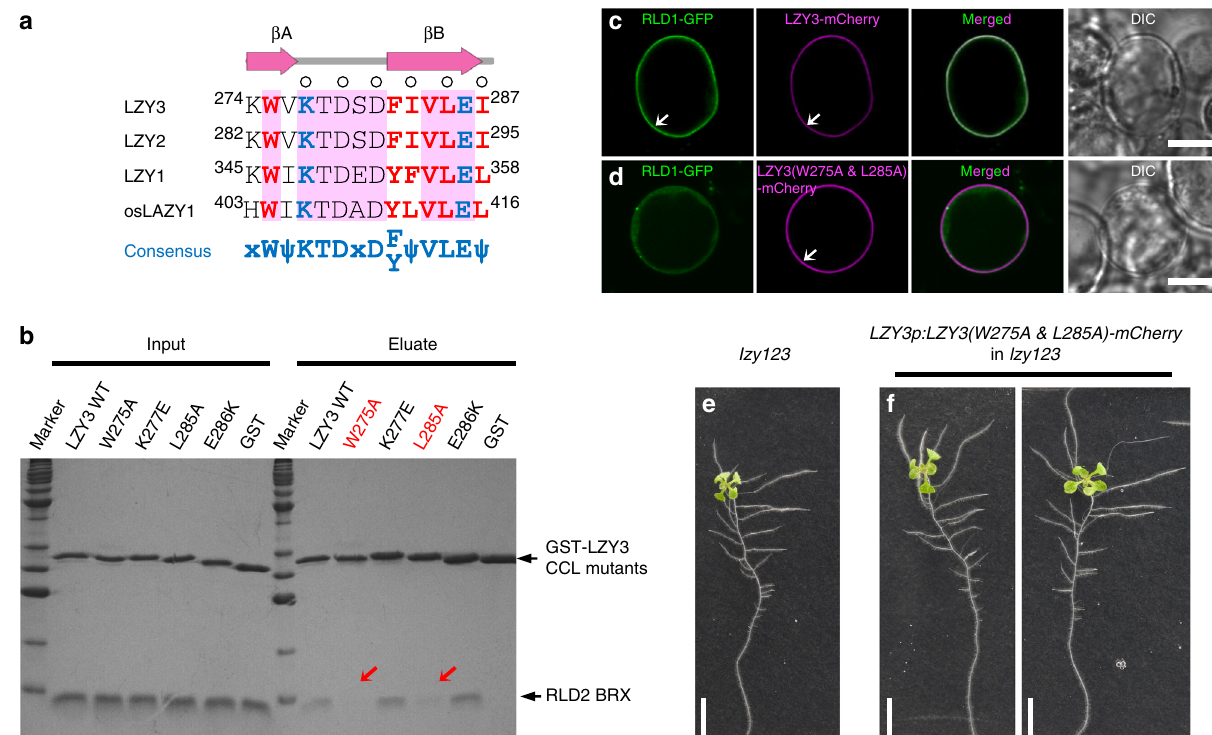
Fig. 5 The disruptive mutations of the CCL-BRX interaction interfered with LZY3 function. a Sequence alignment of LZYs CCL with the secondary structures are shown at the top with β -strands (arrowhead). The conserved sequences are fi lled in pink. Residues whose side chain atoms form inter- molecular hydrogen bonds and residues making intermolecular van der Waals contacts are colored in cyan and red, respectively, while residues whose main chain form inter-molecular hydrogen bonds are indicated with open circle. In the consensus sequence, Ψ represents a hydrophobic residue, while x represents any residue. b Pull-down binding assay. RLD2 BRX domain was pulled down with GST-LZY3 CCL (WT and mutants) and analyzed by SDS- PAGE. Arrows indicate the reduced abundance of RLD2 BRX. c , d The importance of CCL-BRX interaction in LZY3-dependent RLD recruitment to the plasma membrane. Co-expression of RLD1-GFP with wild-type LZY3-mCherry ( c ) and LZY3-mCherry carrying mutations in CCL ( d ) in Arabidopsis protoplast cells. e , f Complementation test. Ten-day-old seedlings of lzy1 lzy2 lzy3 ( e ) and lzy1 lzy2 lzy3 uncomplemented by LZY3-mCherry carrying mutations in CCL driven by control of the LZY3 promoter ( f ). Scale bars, 10 μ m ( c , d ) and 1 cm ( e , f